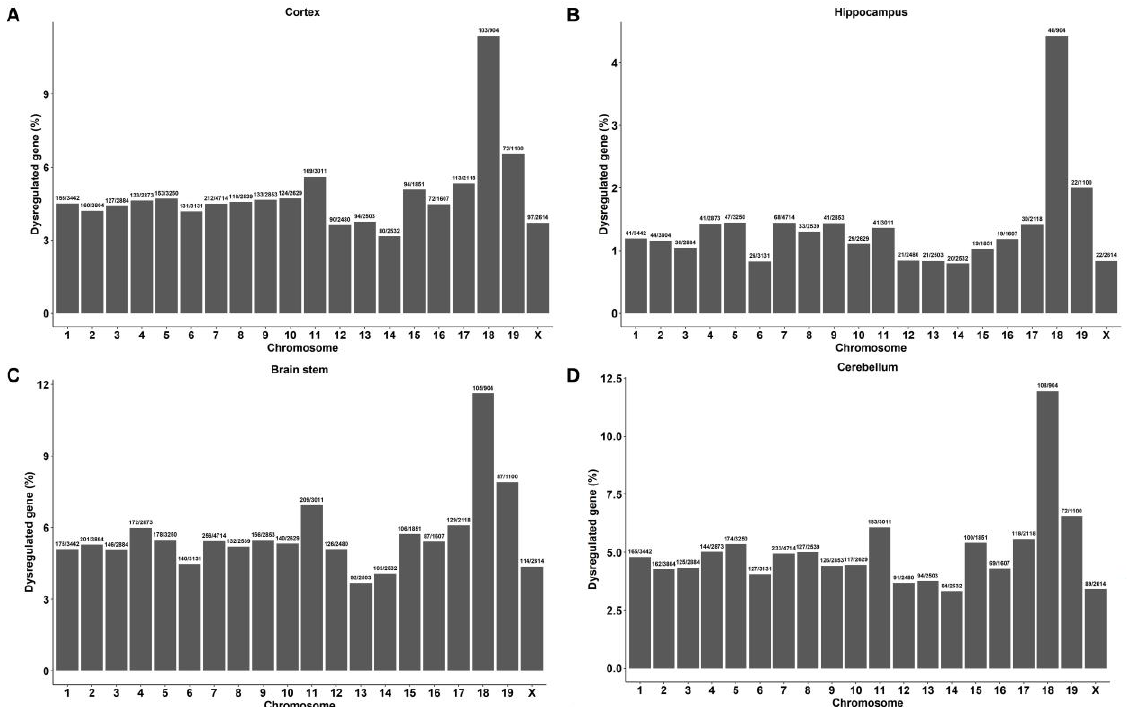
Figure 2. Chromosome distribution of significantly regulated genes in different regions of male DAPK1-KO mouse brain tissues. Chromosome distribution of DEGs in the cerebral cortex ( A ), hippocampus ( B ), brain stem ( C ) and cerebellum ( D ).